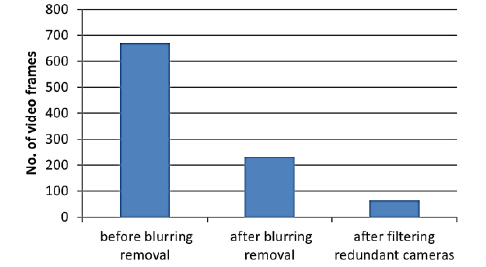
Figure 18. Number of video images of the monument before and after filtering.